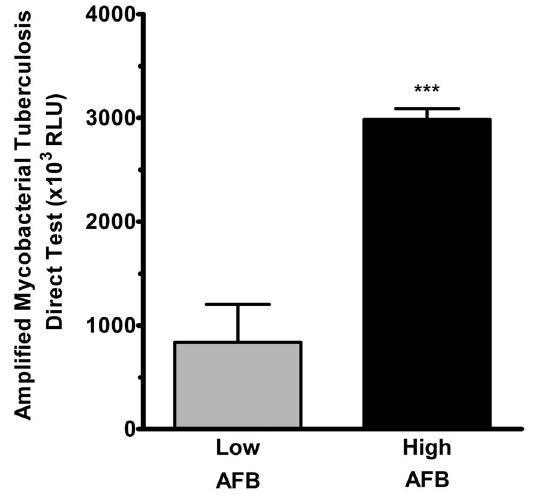
Figure 1. Increased intracellular ribosomal RNA in AM from TB patients. The Amplified Mycobacterium Tuberculosis Direct (AMTD) test that measures the intracellular ribosomal RNA in AM of pulmonary TB patients is significantly higher in patients with high M. TB load of sputum (High AFB, n=6) than that of patients with low sputum bacterial load (Low AFB, n=6). Data are mean 6 SE. *** p , 0.001.